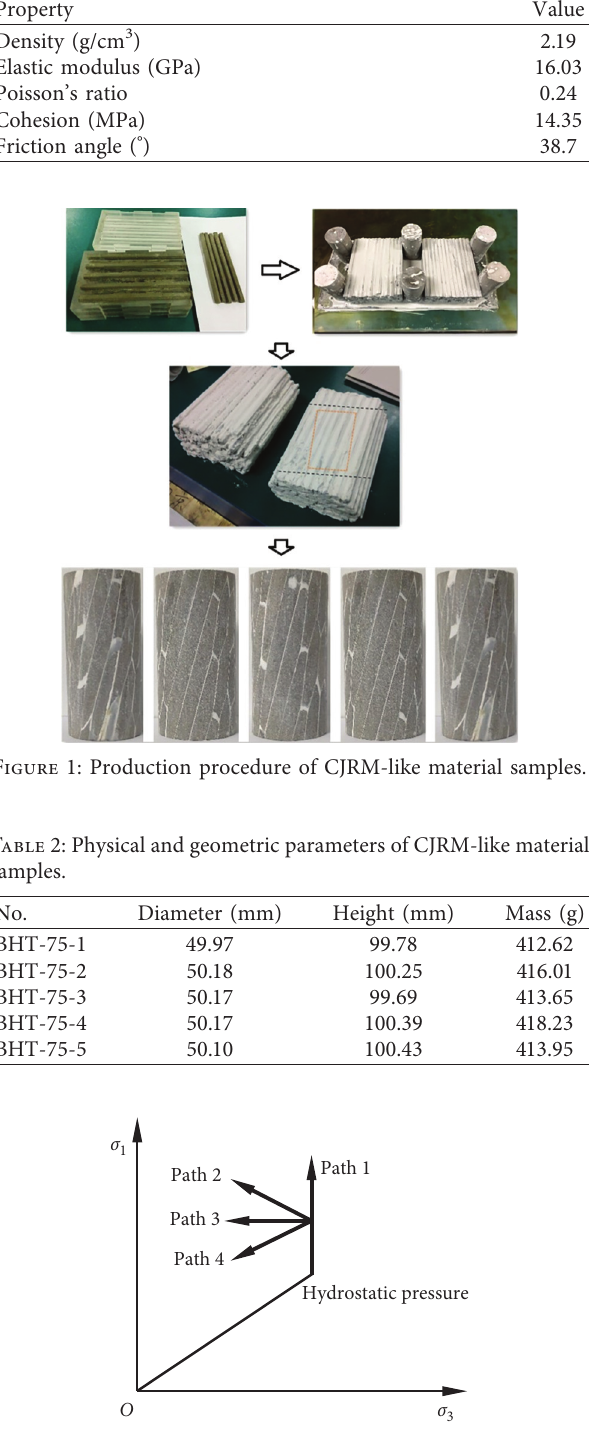
Figure 2: Stress paths of four triaxial unloading test